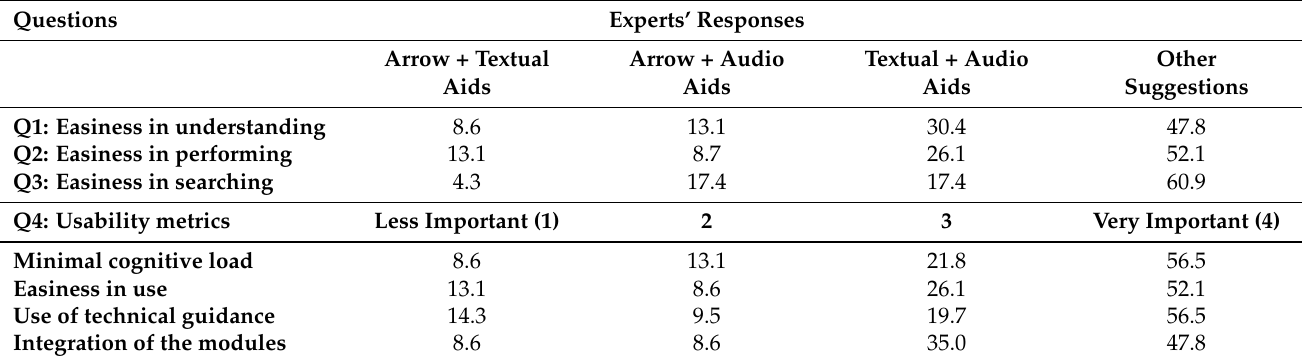
Table 9. Experts’ Responses (Participants = 23). Each cell indicates the %age value.